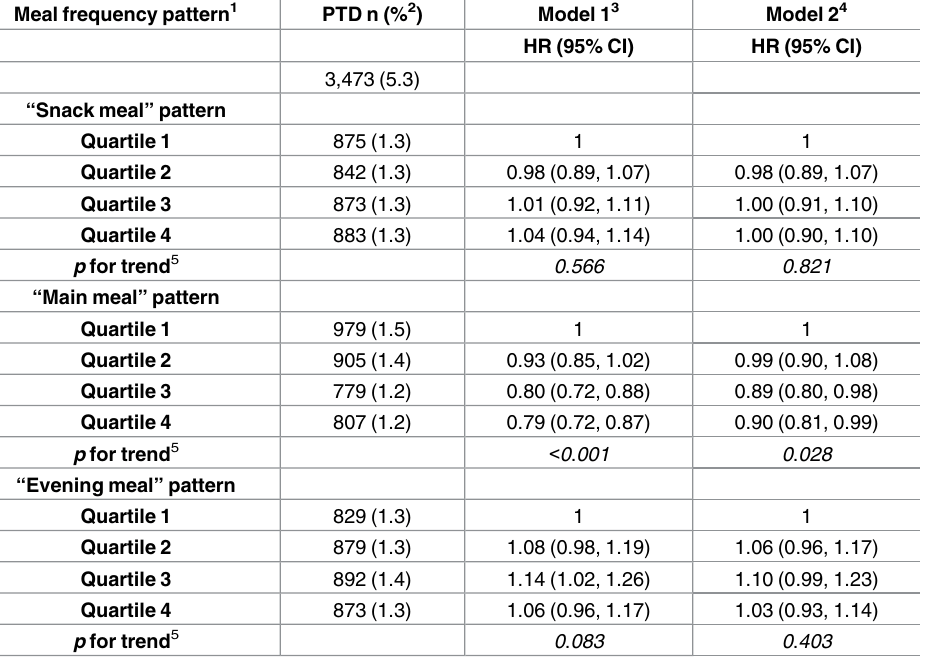
Table 2. Associations between meal frequency patterns and preterm delivery in 65,487 pregnant women in the Norwegian Mother and Child Cohort Study (MoBa) Meal frequency pattern